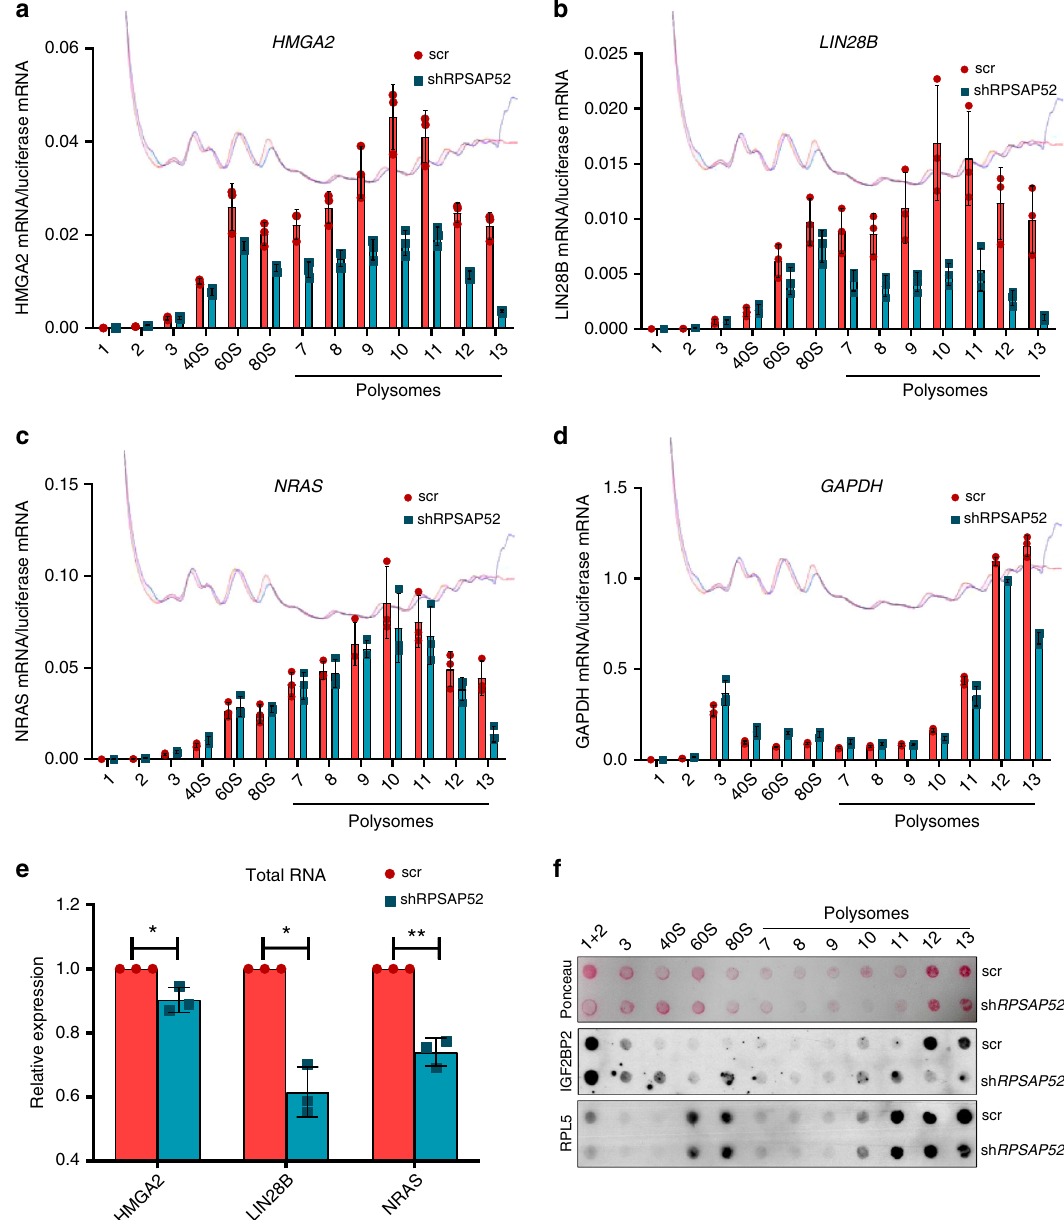
Fig. 6 IGF2BP2 is redistributed on polysome gradients upon RPSAP52 depletion. a – d Polysome pro fi les of A673 cells stably depleted of RPSAP52 (shRPSAP52, corresponding to sh4 B11 clone) or control cells (scr). HMGA2 mRNA ( a ), LIN28B mRNA ( b ), or NRAS mRNA ( c ) distribution across the gradient was evaluated in each fraction by RT-qPCR. For comparison, GAPDH mRNA distribution was also assessed ( d ). Graphs represent the mean ±SD of three replicates. The red and blue lines indicate absorbance at 260 nm for each fraction in control or depleted cells, respectively. e Total RNA from the same cells ( n = 3) was analyzed by RT-qPCR. Mean values are shown ±SD. A two-tailed student t -test was used (* P < 0.05, ** P < 0.01). f P rotein extracted from the 20% of the polysome pro fi le fractions shown in ( a – d ) were subjected to dot blot analysis with an anti-IGF2BP2 antibody (middle panel) or with anti-RPL5 antibody as control (lower panel). Proteins from 10% of fractions 1 and 2 were loaded together. Membranes were previously stained with Ponceau S (top panel) for loading control. Source data are provided as a Source Data fi